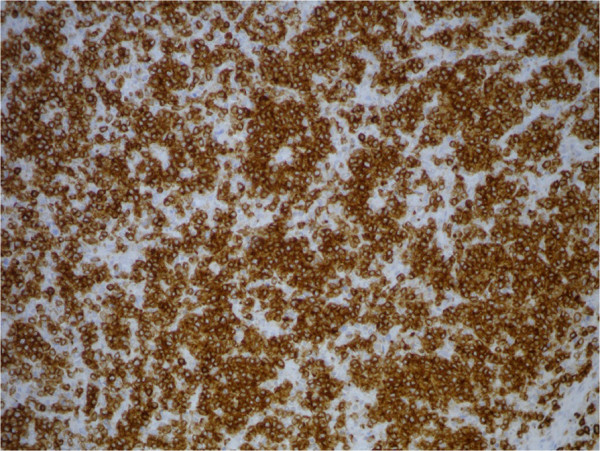
Spleen: CD3 IHC, 20×.